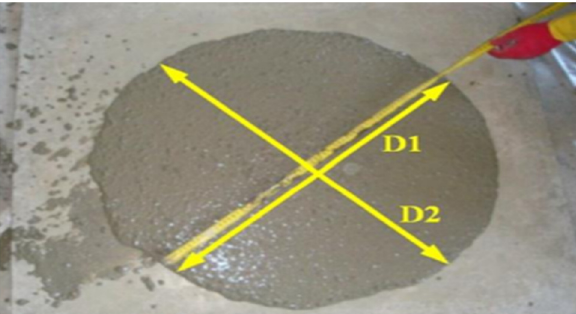
Figure 2: Determination of the fl ow diameter of the mixture ( fl ow spread S, mm ) .